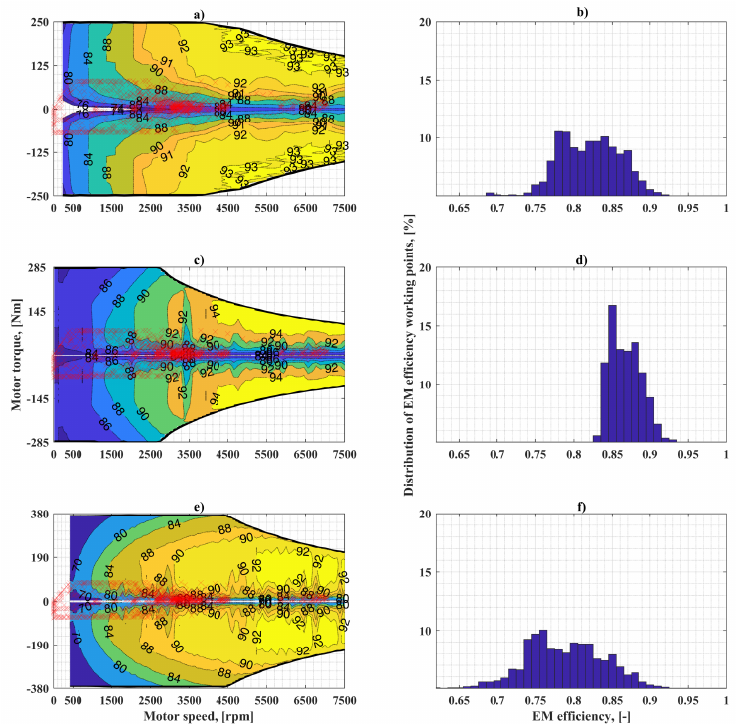
Figure 7. Working points on the UDDS cycle with different EMs installed on BMW i3 BEV. EMs with original characteristics ( right column) and distribution of their efficiency working points ( left column) for: BMW i3 EM ( a , b ); Kia Soul EM ( c , d ) ; YASA EM ( e , f ).